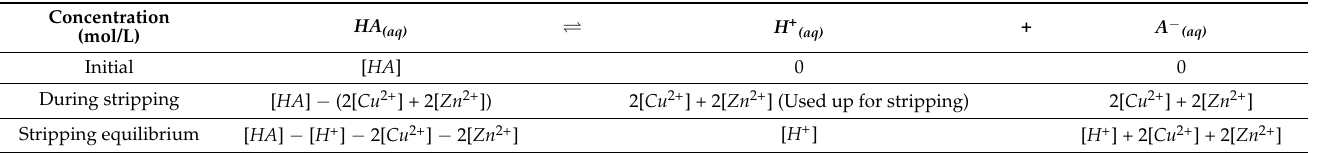
Table 1. Change in [ HA ], [ H + ], and [ A − ] during stripping and their concentrations attained at stripping